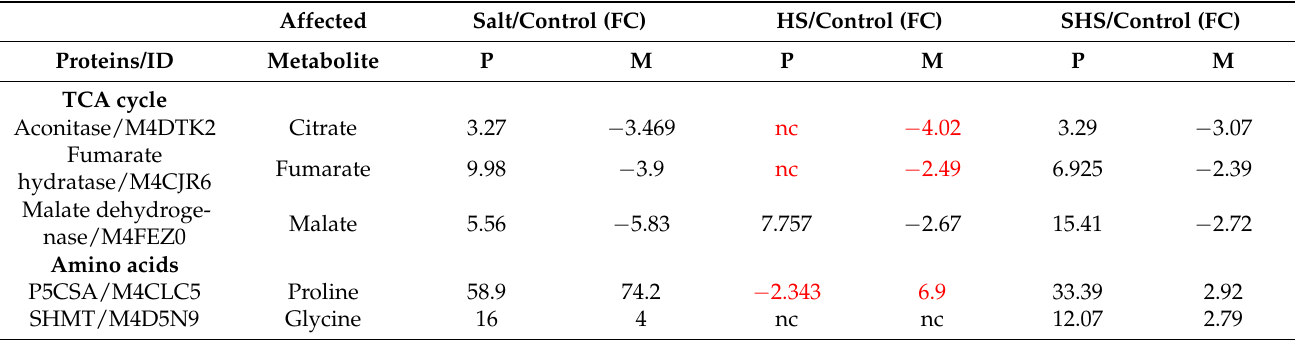
Table 2. Relationship between proteins and metabolites. Fold change (FC) ratio of proteins and metabolites between treatments and control ( p value < 0.05). P, protein; M, metabolite. No correlation between protein and metabolite levels is colored